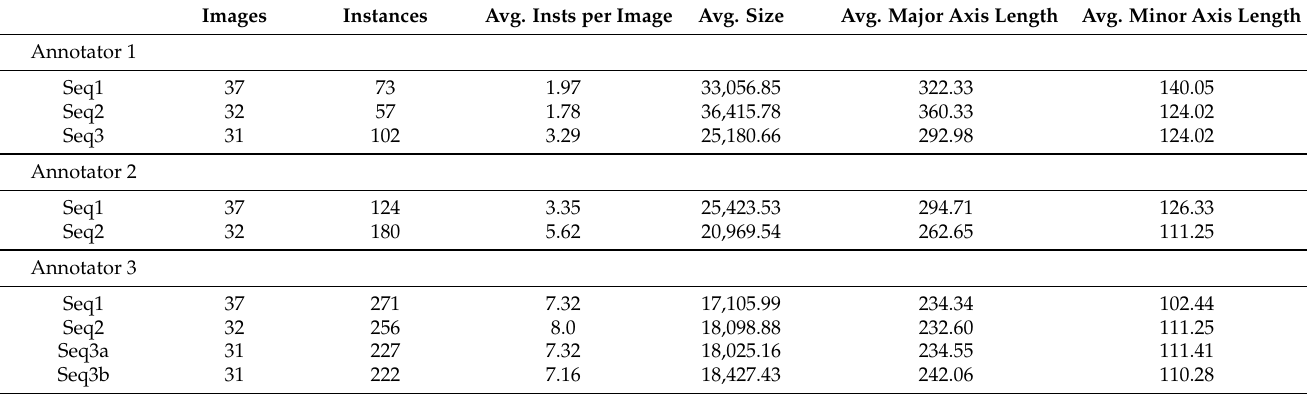
Table 3. Annotation statistics for overlengths for three different annotators. Each numbered sequence contains images harvested with the same machine settings.